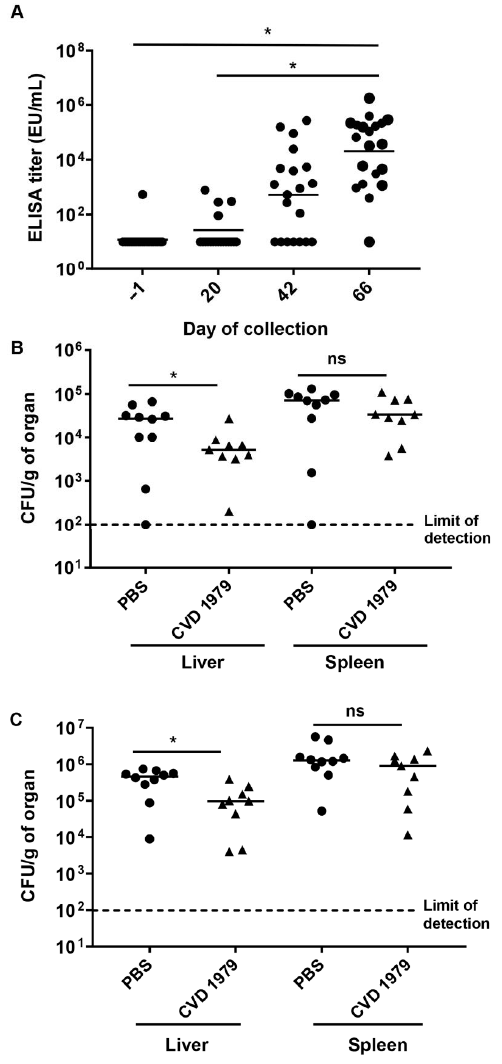
Figure 1. Immunogenicity and protective efficacy of live attenuated Salmonella Newport vaccine CVD 1979 in BALB/c mice. ( A ) Anti-LPS serum IgG titers in mice immunized orally with 3 doses of 10 9 CFU of vaccine. Mice were bled before each immunization and challenge. Serum anti-LPS IgG antibody titer was determined for individual mice by ELISA. Black bars represent the geometric mean. Significant differences were determined using Tukey’s multiple comparisons test. ( B ) Bacterial burden in the liver and spleen of mice immunized with PBS or CVD 1979. One month after the 3rd immunization, mice were challenged intraperitoneally with a low dose (4.3 × 10 5 CFU) of S . Newport Chile 361. ( C ) Bacterial burden in the liver and spleen of mice immunized with PBS or CVD 1979 and subsequently challenged with a high dose (1.4 × 10 7 CFU) of S . Newport Chile 361. Two days post-infection, mice were euthanized, and their liver and spleen were collected. Organs were homogenized, and dilutions were spread onto HS plates for colony (CFU) counting. Bacterial loads are expressed as CFU per gram of organ. Black bars represent the median; significant difference was determined using two-tailed Mann – Whitney test. * p < 0.05; ns, not significant.